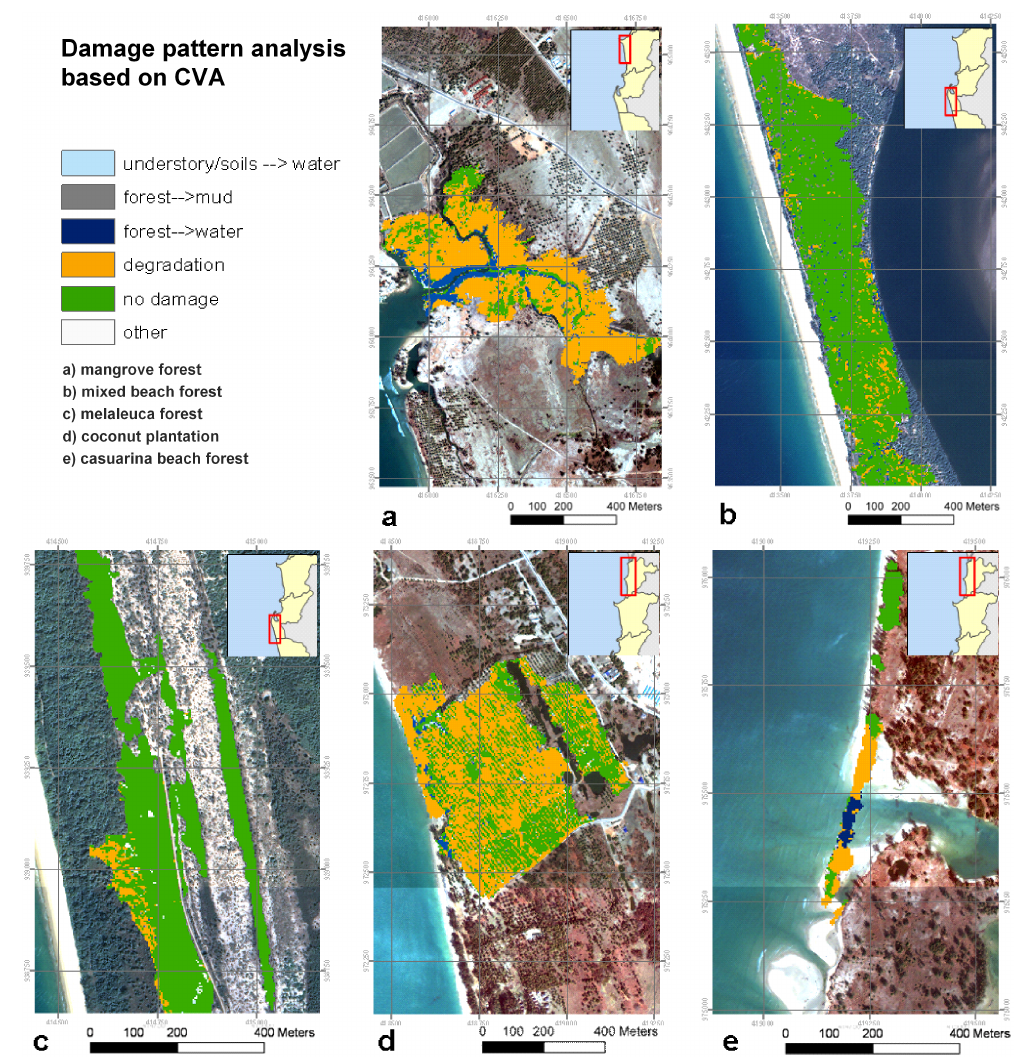
Fig. 12. Change maps based on CVA, illustrated for the five coastal forests in the Phang-Nga province.